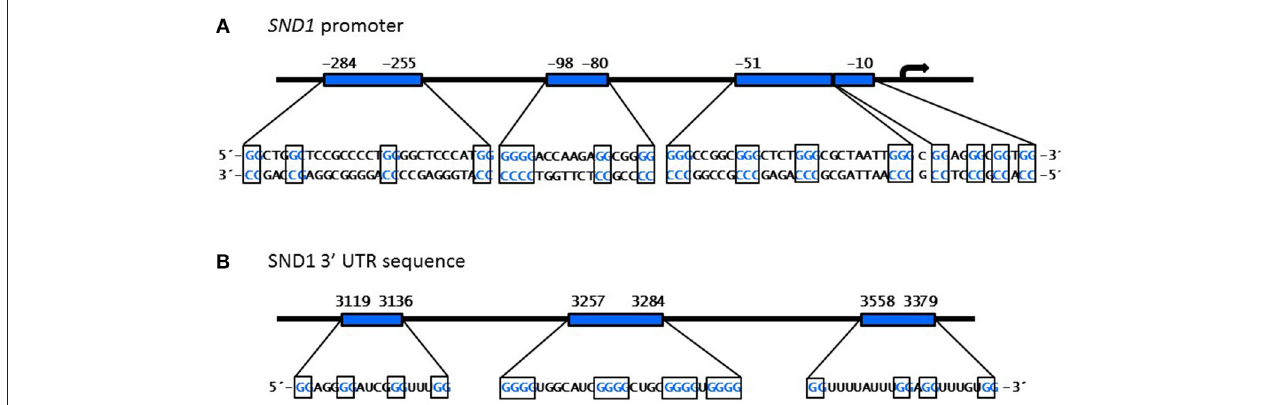
FIGURE 5 | Predicted G-quadruplex structures in the SND1 proximal promoter and the 3 ′ UTR sequence. In silco prediction and distribution of the quadruplex forming G-rich sequences (each G-group in boxes) found by QGRS Mapper program (91) in the nucleotide sequence of human SND1 promoter (A) and 3 ′ untranslated region (B)